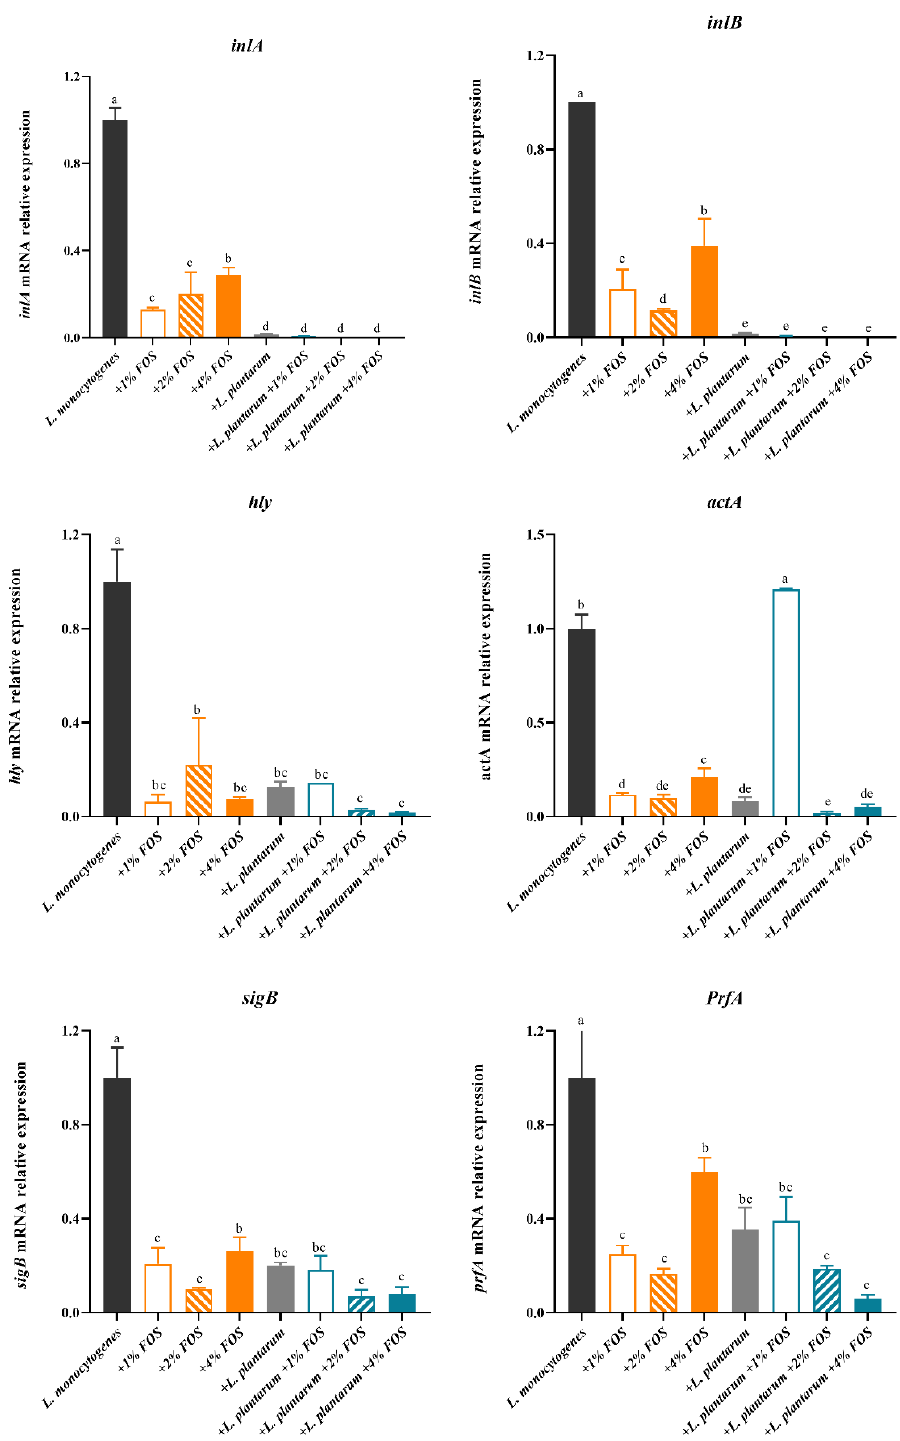
Figure 6. Relative expression levels of virulence genes of L. monocytogenes in BHI at 25 °C for 40 h in different treatment groups: (1) the untreated group (black bar), (2) 1% ( w / v ) FOS (orange hollow bars), (3) 2% ( w / v ) FOS (slash orange bars), (4) 4% ( w / v ) FOS (orange bars), (5) L. plantarum supplementation group (dark gray bars), (6) L. plantarum + 1% ( w / v ) FOS (blue hollow bars), (7) L. plantarum + 2% ( w / v ) FOS (slash blue bars), (8) L. plantarum + 4% ( w / v ) FOS (blue bars). Values are mean ± SD ( n = 6). At each temperature, different lowercase letters (a, b, c, d, and e) indicate significant differences ( p < 0.05) among